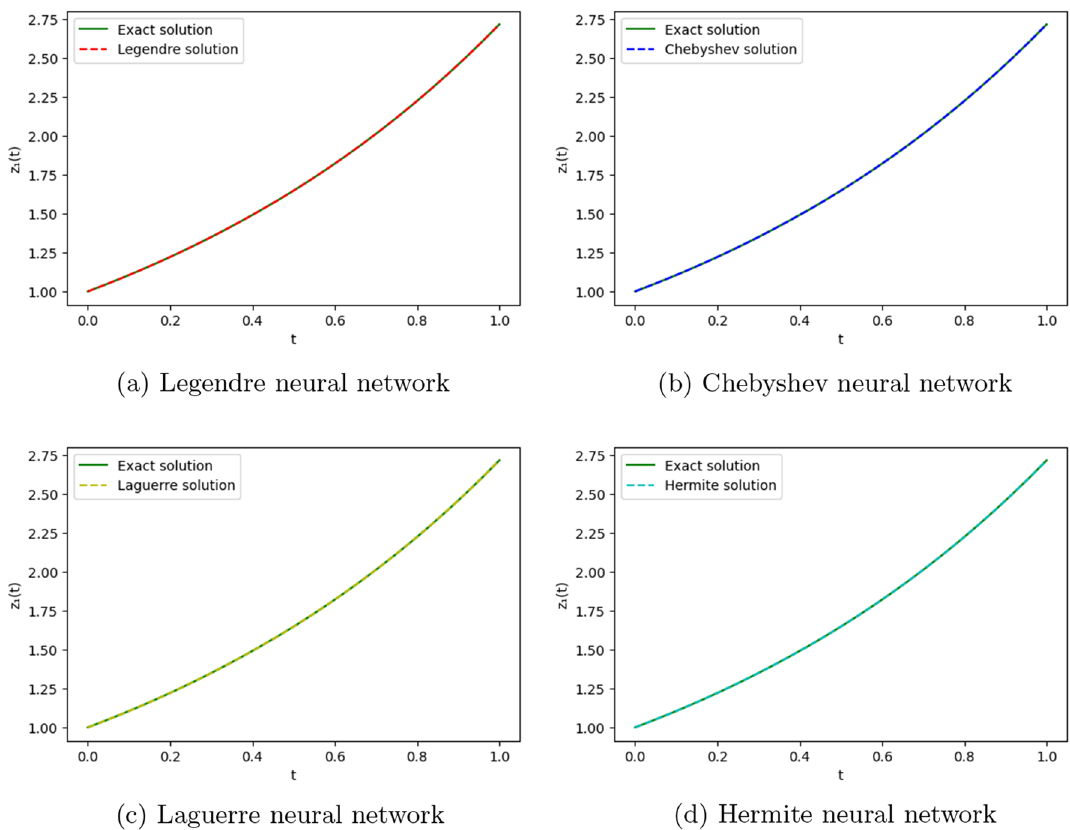
Figure 12. Comparison of the exact solution z 1 ( t ) with the obtained approximate solutions of Example